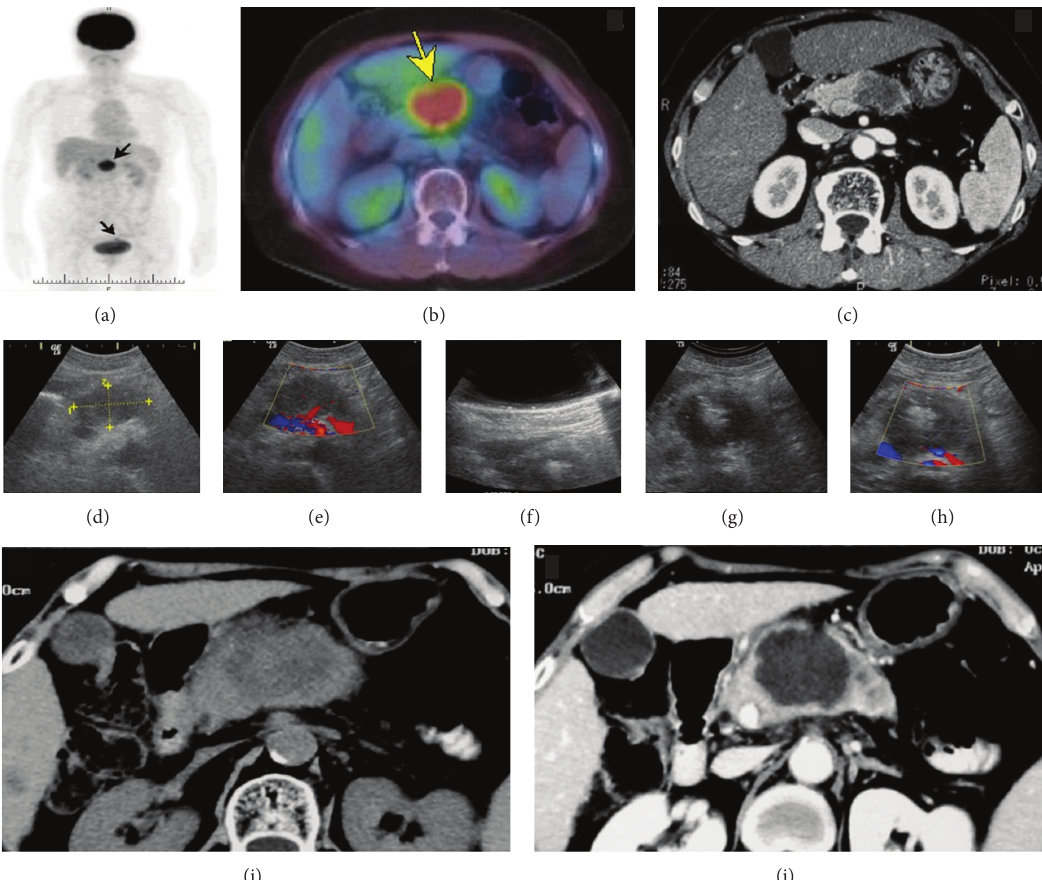
Figure 1: A 64-year-old woman with about 4.9 × 3.5 × 2.9 cm pancreatic body carcinoma. The pre-HIFU isotope scan (a) and PET-CT (b) showed a clear radioactive concentration in pancreas area. The enhanced CT (c) showed low-density lesions in pancreatic body with internal mild heterogeneous enhancement and marginal mild enhancement. Ultrasound showed hypoechoic lesions (d) with clear boundary, internal homogeneous ultrasound reflection, and small blood flow signals (e). In the 6th HIFU treatment, significant increase of ultrasound reflection intensity from tumor central area (f) was observed by ultrasound. Air-like hyperechoic ultrasound reflection (g) without blood flow signals (h) from inside of the tumor was observed by abdominal wall scanning. A month later, CT and enhanced CT showed tumor volume increase with internal uneven low density, no enhancement ((i), (j)), and tumor ablation ratio over